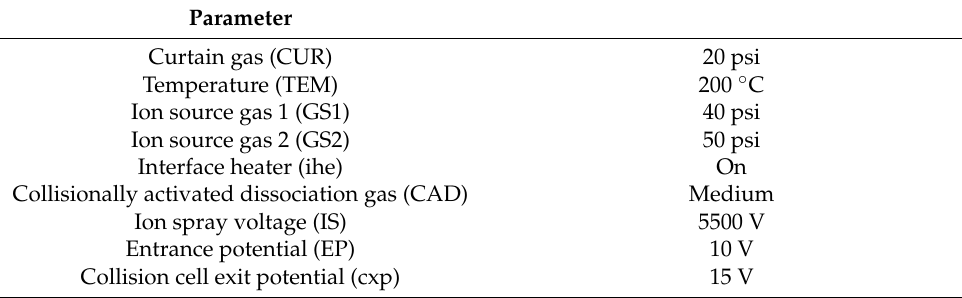
Table 2. Parameters for the detection of different lipid